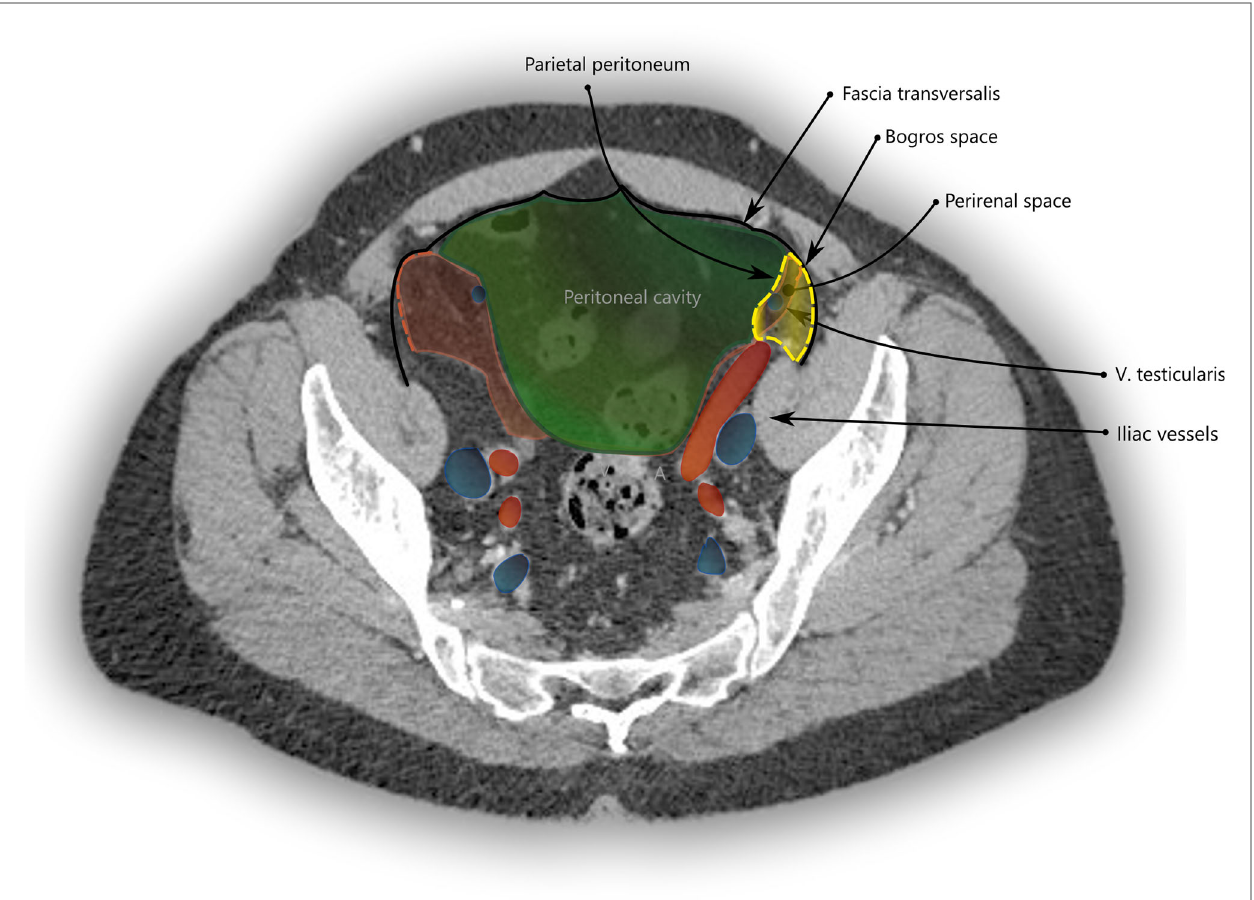
FIGURE 3 | CT imaging with a transverse section through the pelvis at the apex of the urinary bladder. The space of Bogros is marked in yellow and limited by the TF (black) laterally and the parietal peritoneum (green) medially. It contains the extension of the perirenal space (red) into the